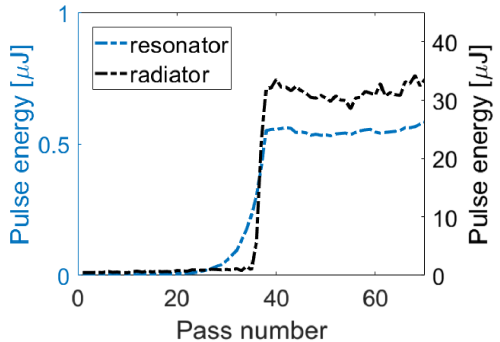
FIG. 9. Overview of the photon pulse energy per pass in the resonator (at the end of the modulator, left scale) and in the radiator (at the end of the radiator, right scale) for the case starting from shot noise.